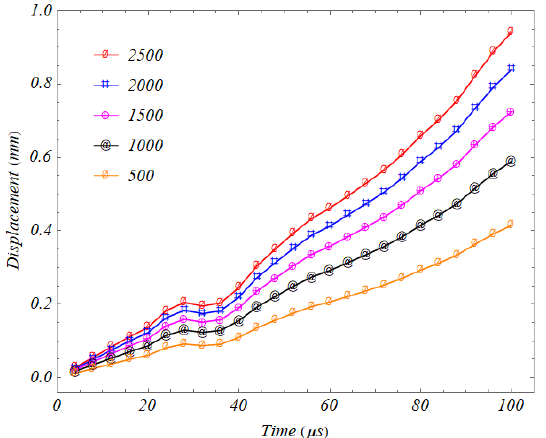
Fig. 31. Displacement against time for various drop distances with three cell phone casing